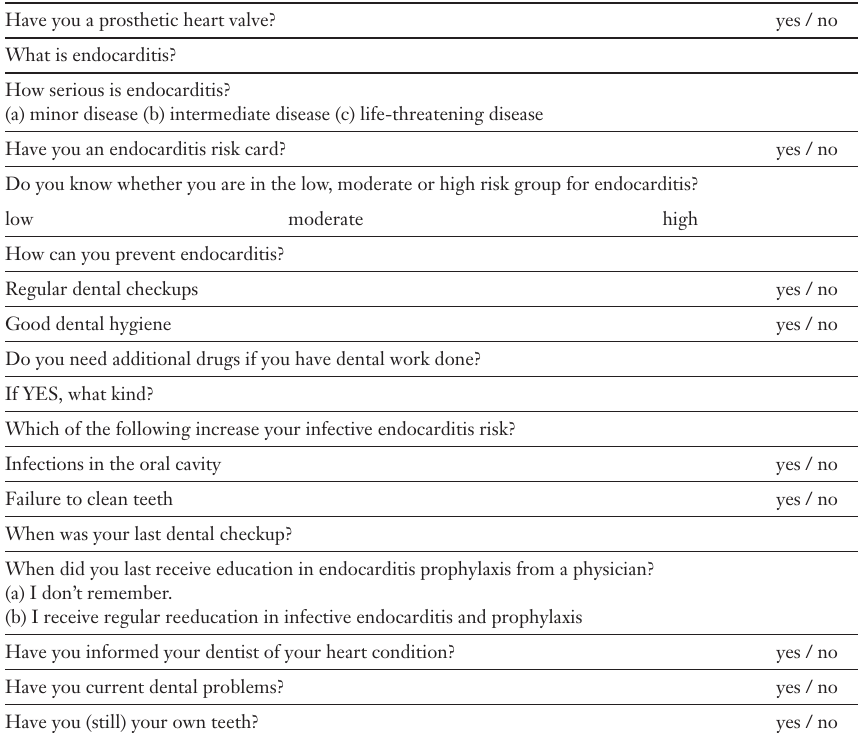
Table 1 Patient questionnaire on